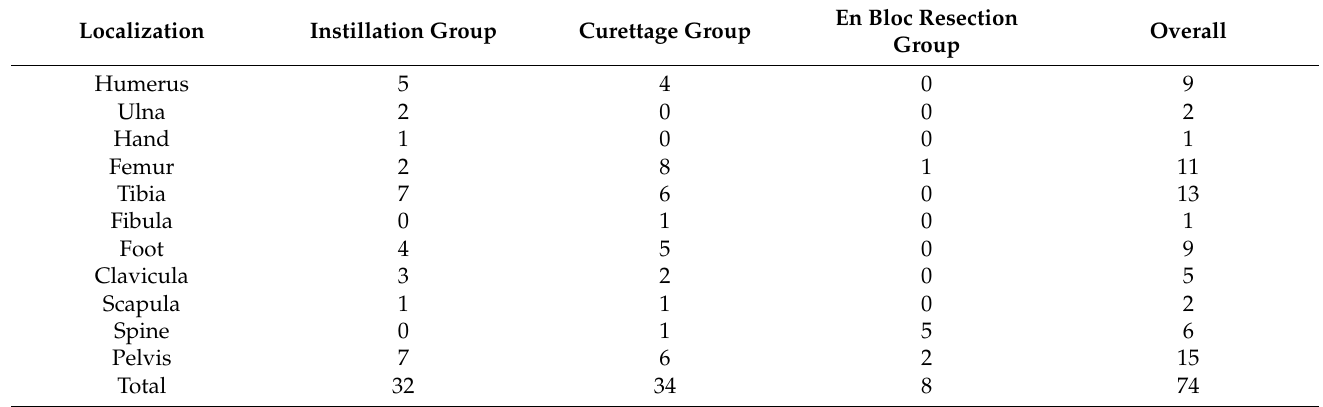
Table 3. Overview of the affected